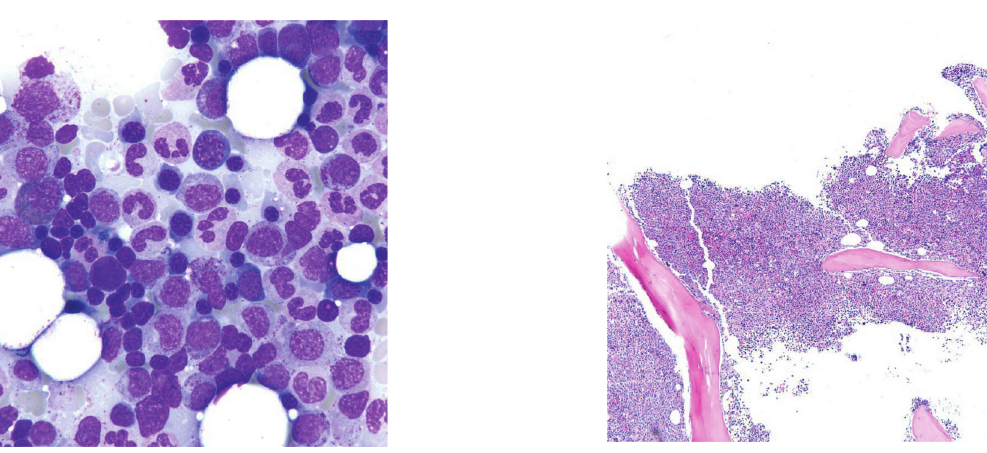
Figure 8: Marked hypercellular bone marrow for age (90% cellu- larity), with slight dyserythropoiesis (hematoxylin-eosin, original magnification ×